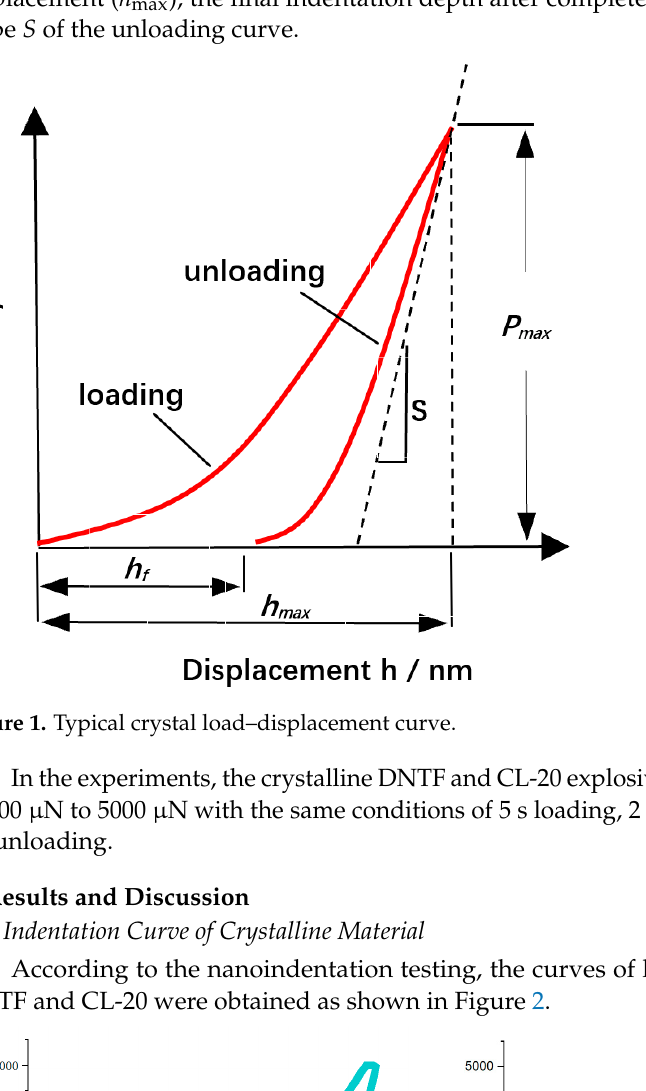
( b ) Figure 2. Quasi-static load–displacement curve for DNTF ( a ) and CL-20 ( b ). The curves obtained exhibited similarity to the theory curve above. With the increase in loading, the maximum depth of the indenter ( h max ) and the final indentation depth ( h f ) increase continuously gradually. During the loading, the displacement on both crystals showed a sudden increase, which was mainly caused by internal microdefects such as microcracks, micropores, etc. When the contact surface of the indenter is close to the de- fect, the elasticity and hardness of the local material will decrease sharply, resulting in the